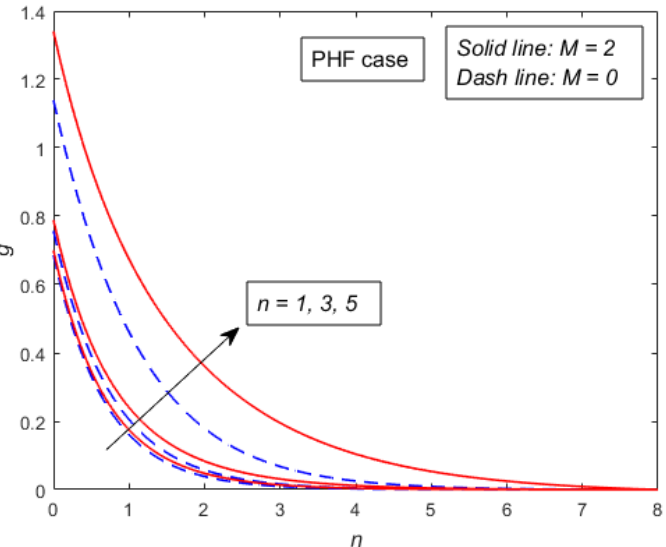
Figure 4. Variation of the temperature profile for different values of nonlinear stretching sheet parameter n and magnetic parameter M for the prescribed heat flux (PHF) case when K = 1, Pr = 0.71, and Ec =